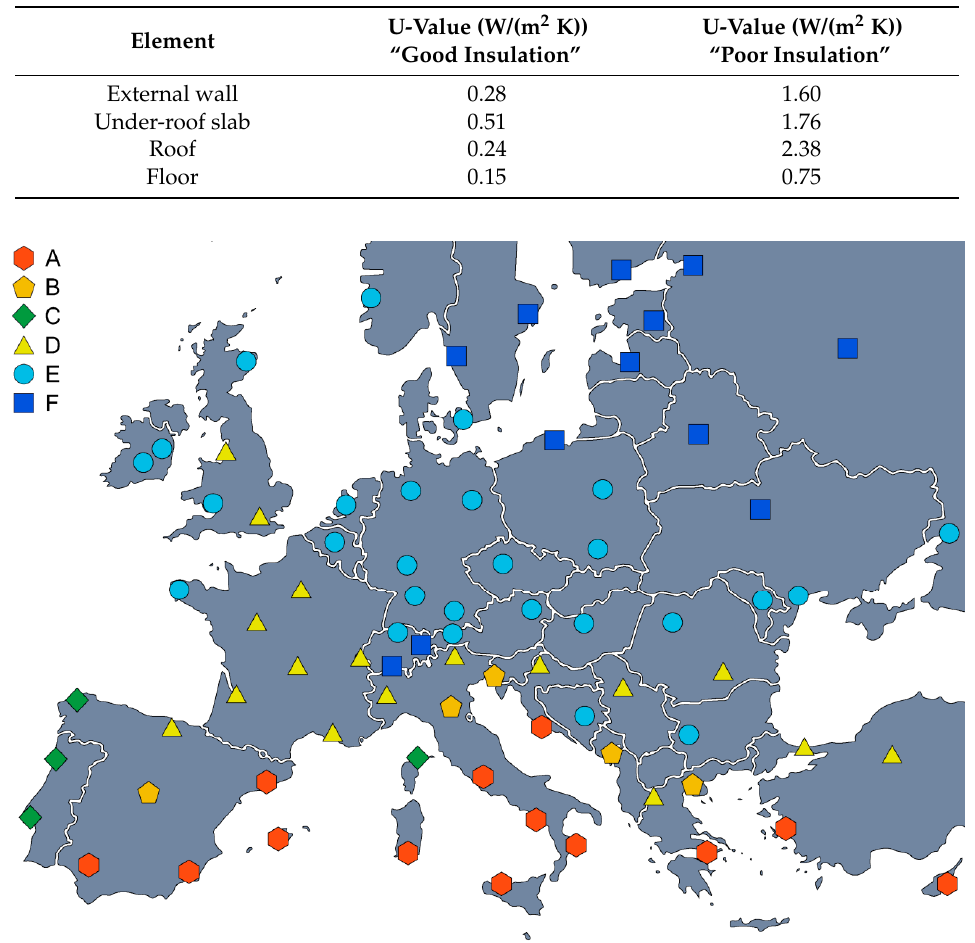
Figure 1. Climatic classification of major European cities according to Heating/Cooling Degree Days (HDD/CDD) criteria reported in Table 4.